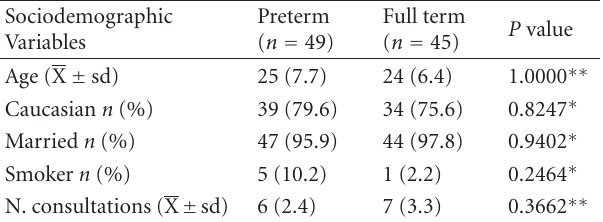
Table 1: Sociodemographic analysis and prevalence of urogenital infections in women in preterm and full-term labor.